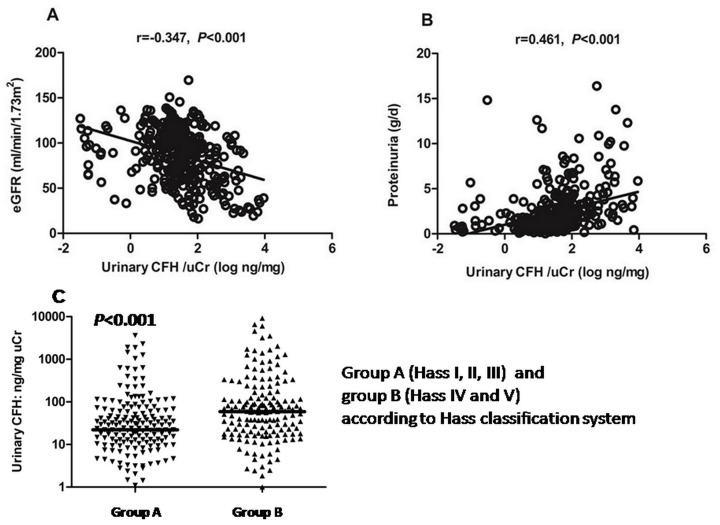
Correlation between urinary CFH levels and clinical/histologic parameters.A. Correlation between urinary CFH levels and baseline eGFR. Urinary CFH levels are shown as log(uCFH/uCr). Spearman correlation analysis was used to determine the correlation between urinary CFH levels and baseline eGFR. Spearman's r = −0.347, P<0.001, and after adjusting for baseline proteinuria r = −0.291, P<0.001. B. Correlation between urinary CFH levels and baseline proteinuria. Urinary CFH level are shown as log(uCFH/uCr). Spearman r-value and the P-value are shown. C. Urinary CFH levels and pathologic changes. Patients were divided into A (Hass I, II and III) and B (Hass IV and V) groups according to the Hass classification system. Urinary CFH levels were compared using the non-parametric Mann-Whitney U test.